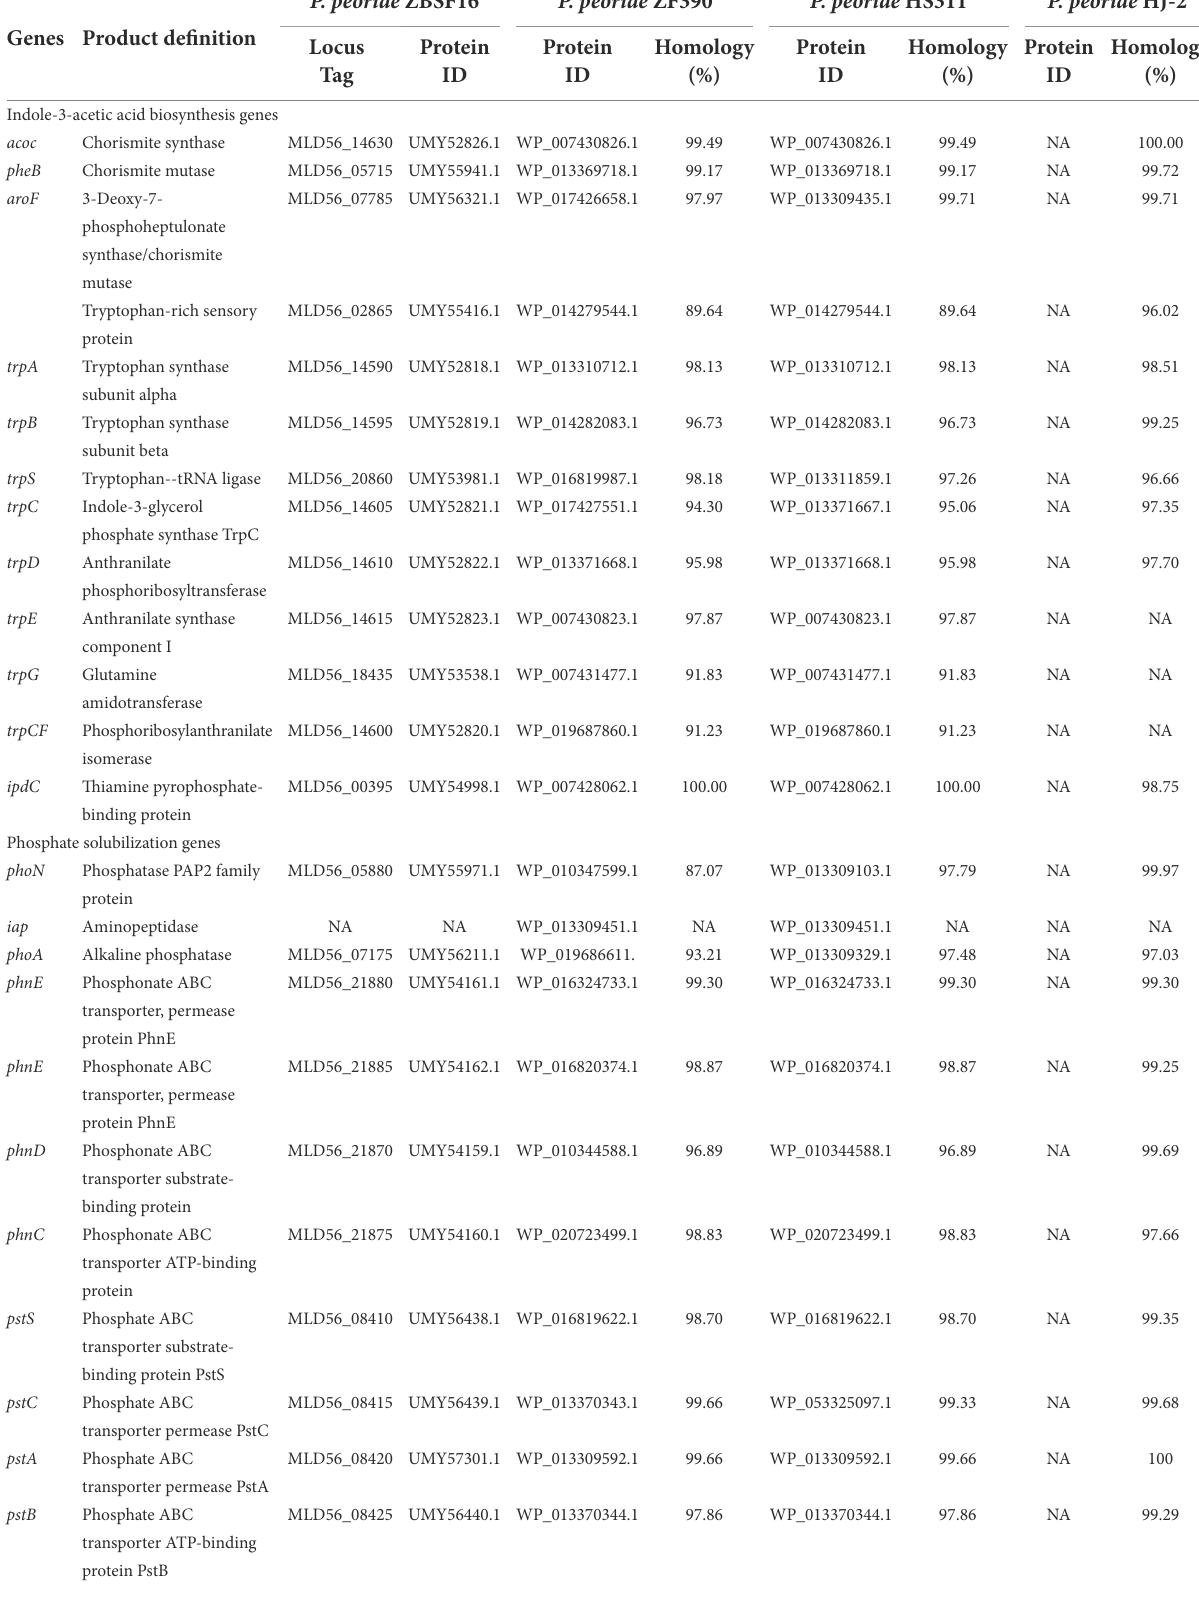
TABLE 2 Homolog analysis of genes involved in plant growth promotion in Paenibacillus peoriae ZBSF16 and other P. peoriae strains.